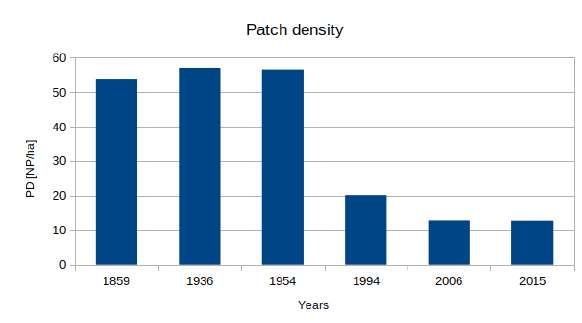
Figure 18. Patch density for forest class change between 1859 and 2015.